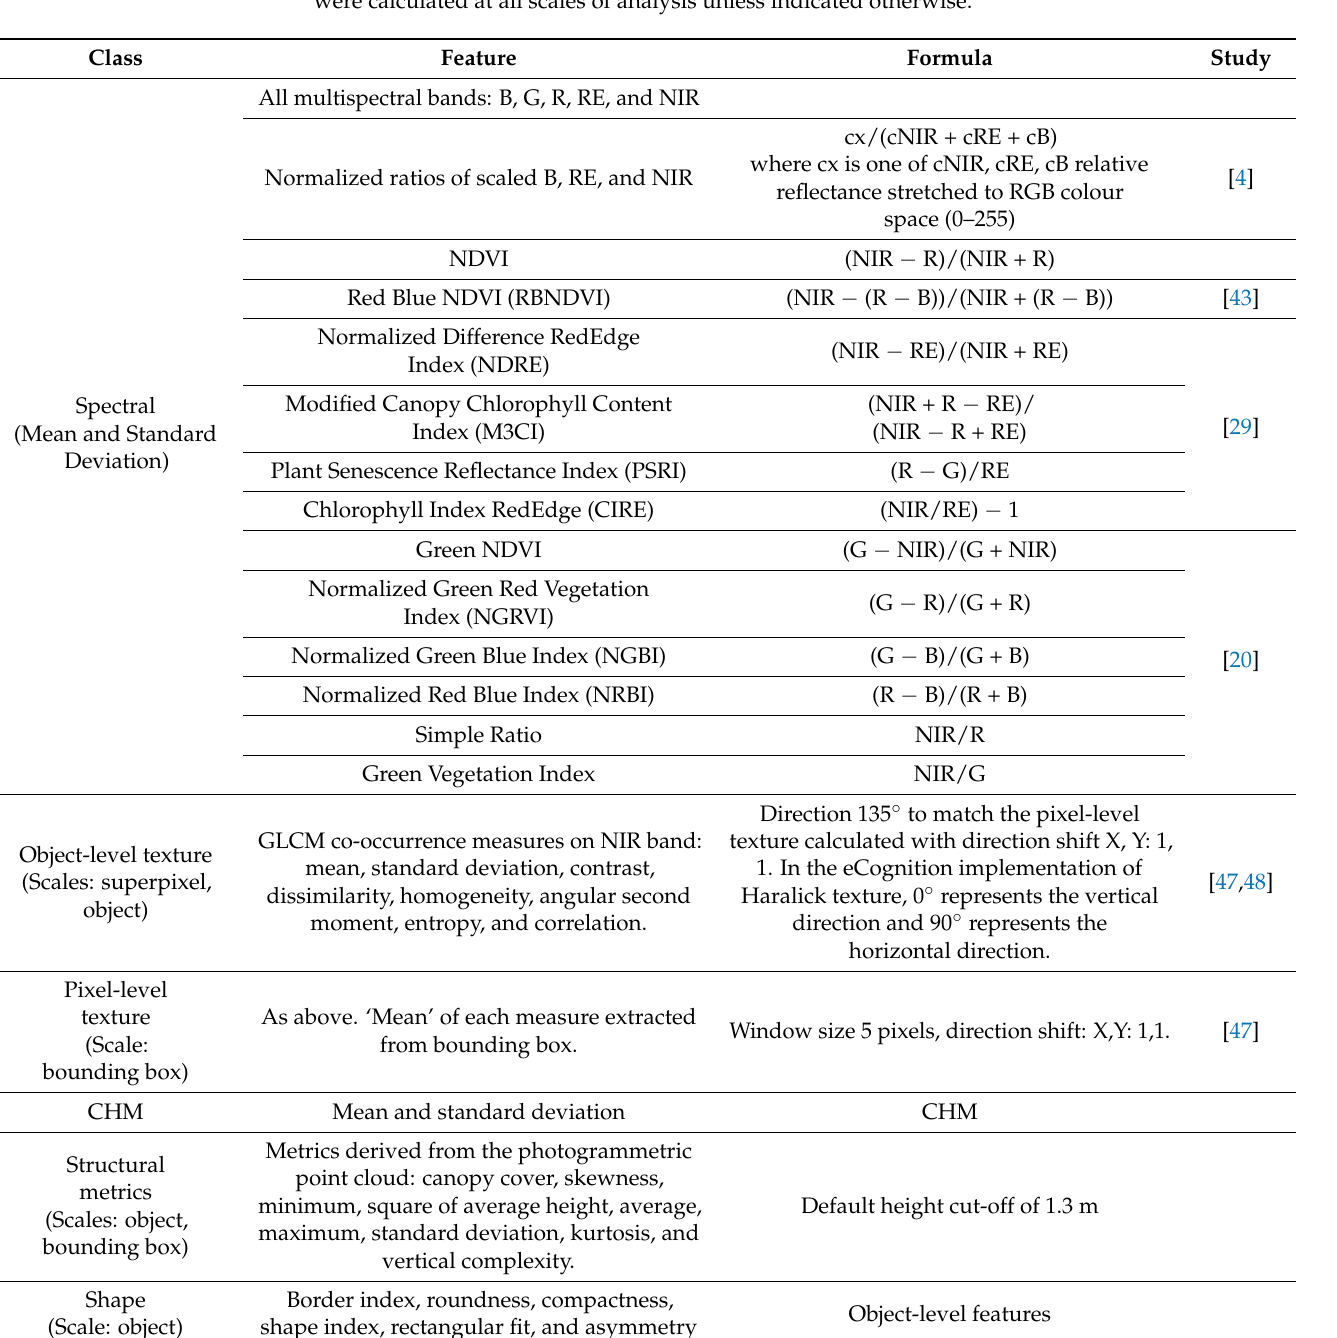
Table 1. List of features used in Random Forest classification for the three scales of analysis. Features were calculated at all scales of analysis unless indicated